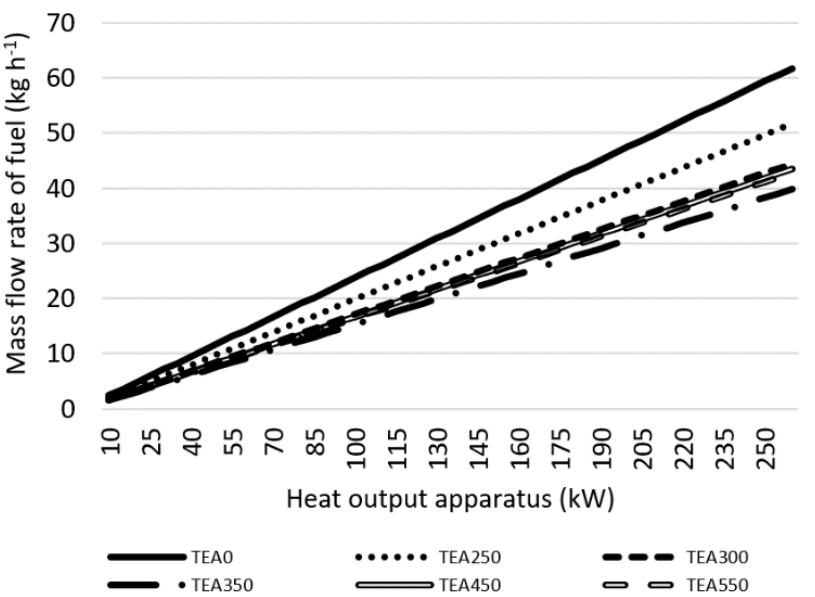
Figure 5. Mass flow rate of fuel fed into combustion chambre to cover the desired heat output of tea waste.